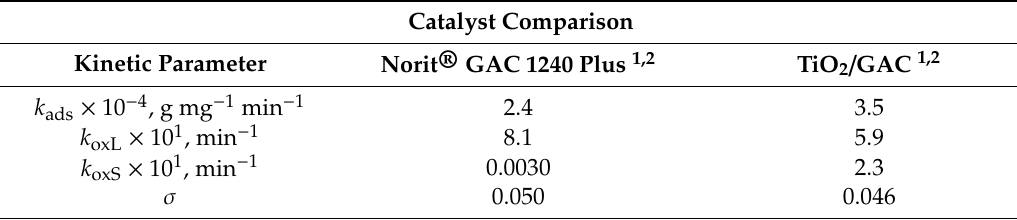
Table 3. Summary of the adsorption and oxidation kinetic constants for the mineralization of wastewater containing aniline using Norit ® GAC 1240 Plus and TiO 2 / GAC composite by catalytic